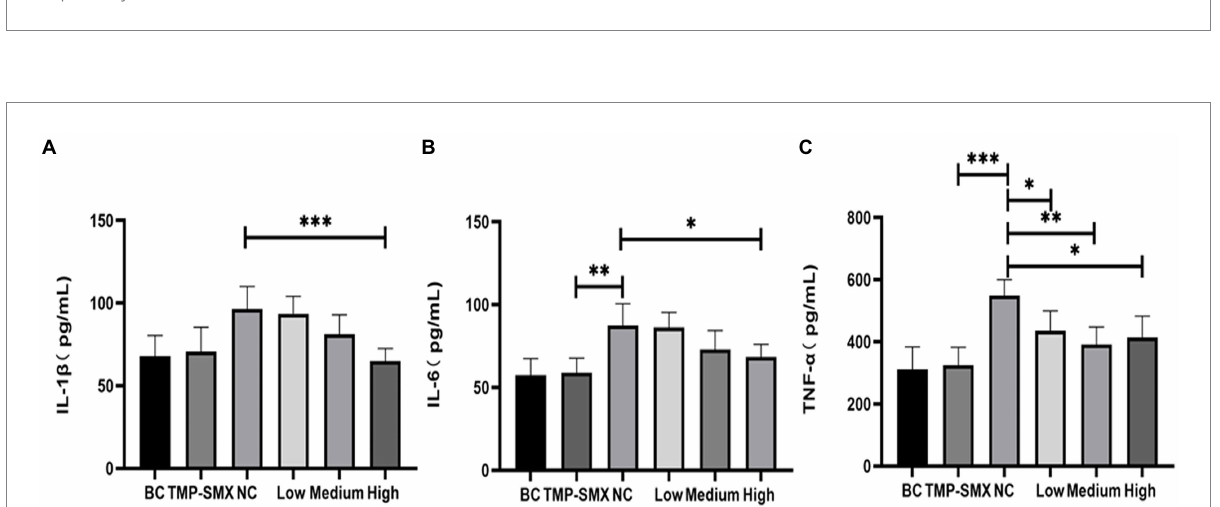
FIGURE 7 Determination of IL-1 β (A) , IL-6 (B) , and TNF- α (C) in mice serum by enzyme-linked immunosorbent assay (ELISA). *indicates p < 0.05, **indicates p < 0.01, ***indicates p < 0.001 when compared with the negative control group (NC, untreated with organic acid of Portulaca oleracea L. [OAPO]). TMP-SMX: trimethoprim-sulfamethoxazole; BC: blank group, uninfected, no drug; NC: infected without the drug; low, medium, and high means groups were given a low, medium, and high dosage of OAPO,